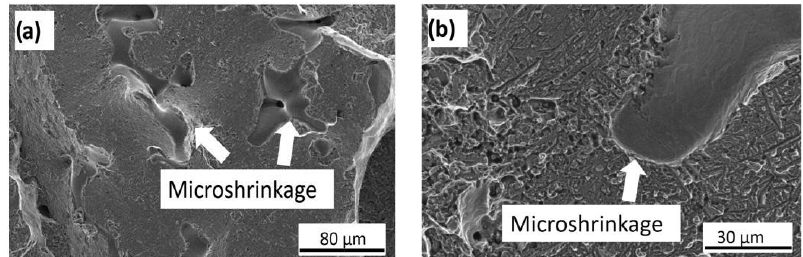
Figure 15. SEM micrographs showing casting defects in last to freeze zones (interdendritic regions) of fracture surface of tensile samples: ( a ) transformed at 280 ◦ C, ( b ) transformed at 330 ◦ C. Small black dots in Figure 13b corresponding to non-metallic inclusions.